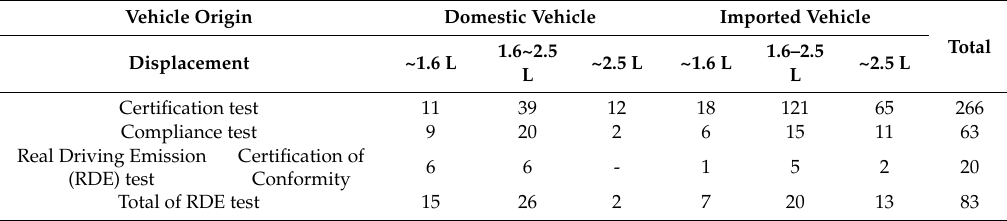
Table 1. Number of car models considered in the analysis of emission characteristics.